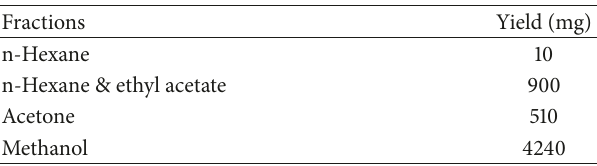
Table 2: Stepwise fractionation of the extracts of tea mangrove with different